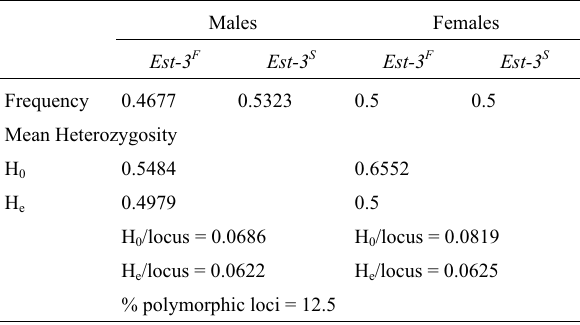
Table II - Allele Frequencies and Mean Heterozygosities for the Est-3 Locus in Male and Female Diatraea saccharalis .